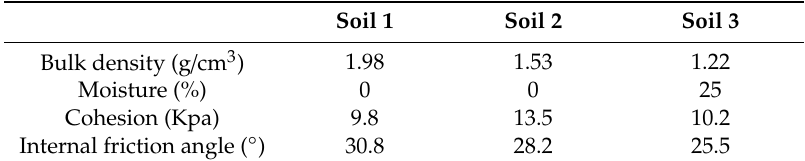
Table 2. Physical properties of experimental soils.